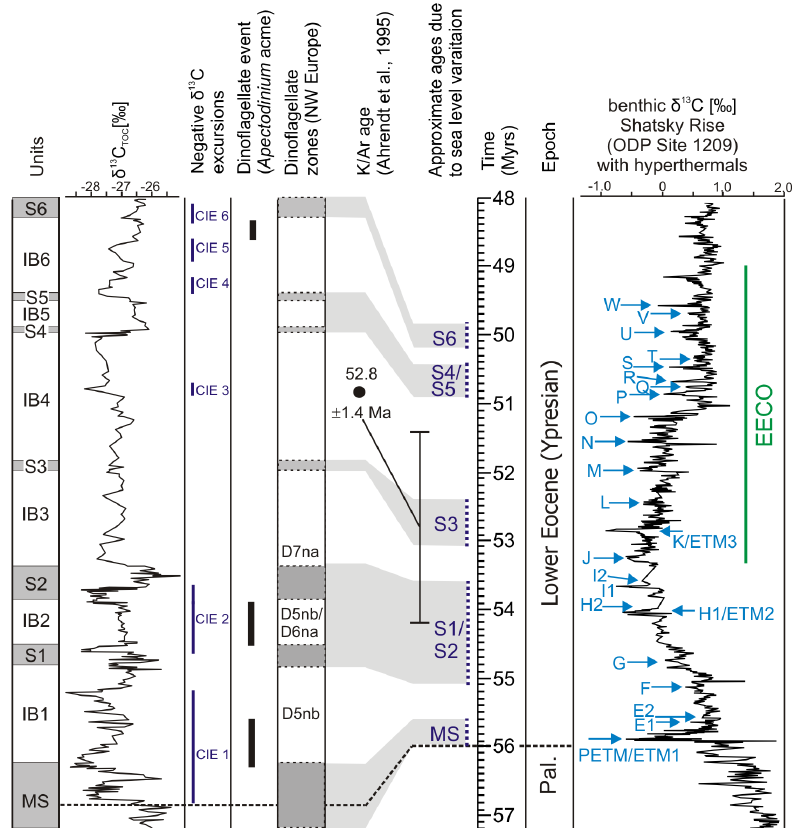
Figure 9. Correlations between lignite and interbed units in the lower part of the Schöningen Formation, δ 13 C TOC values (this work), dinoflagellate ages (this work), K / Ar age (Ahrendt et al., 1995), approximate ages of seams due to sea level fluctuations (this work), and δ 13 C isotopic excursion (CIE) ages (Westerhold et al., 2017, 2018b). Data for the benthic δ 13 C curve from the Shatsky rise (ODP site 1209, northwestern Pacific), as representing a typical deep marine isotope record for this time period, are taken from Westerhold et al. (2018b). The comparison of carbon isotope records from Schöningen and the northwestern Pacific shows that CIE 1 is in the range of the PETM, CIE 2 in the range of the H1–ETM2 and H2 events, and CIEs 3 to 6 in the range of small CIEs known from the marine record, which indicate high-amplitude climate fluctuations during the EECO. Pal.: Paleocene, S: seam, IB: